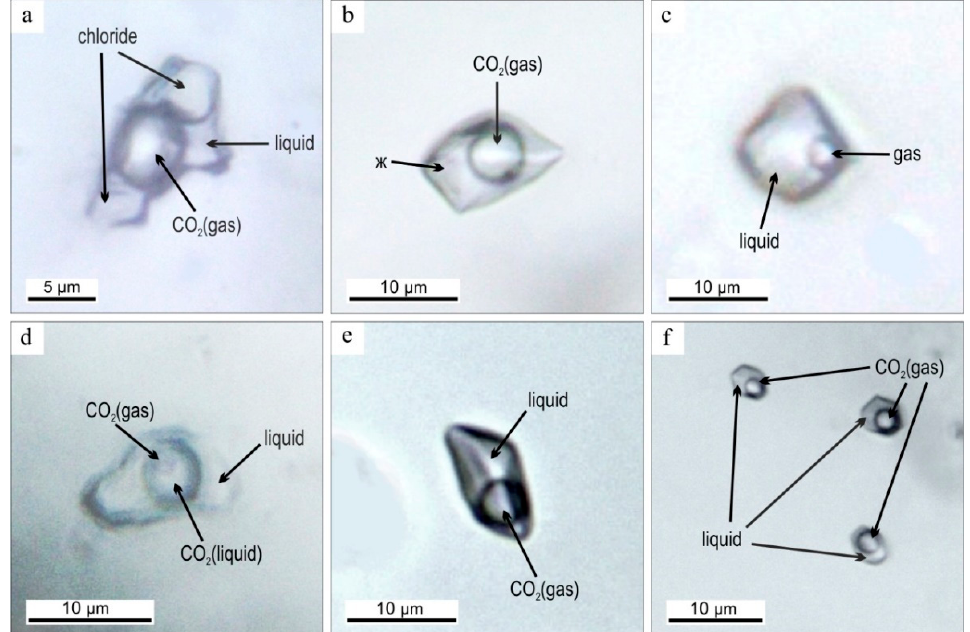
Figure 10. Fluid inclusions in quartz of the Ulug-Sair ore occurrence: ( a ) VLS primary (sample US-4); ( b ) VL pseudosecondary (sample US-4); ( c ) VL secondary (sample US-4); ( d ) VLC primary (sample US-40a); ( e ) VL primary (sample US-40a); ( f ) VL primary/pseudosecondary (sample US-40a). FIA see in Table 2.